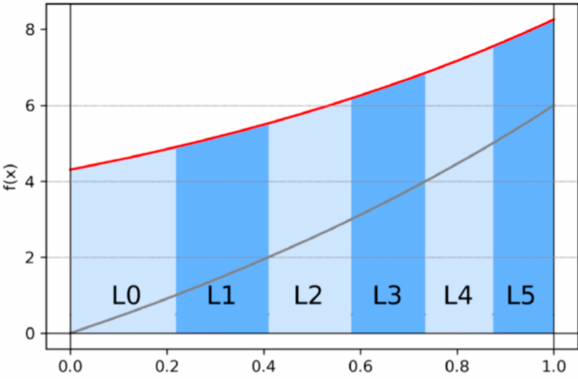
Figure 3. Interval distribution for preparedness levels.